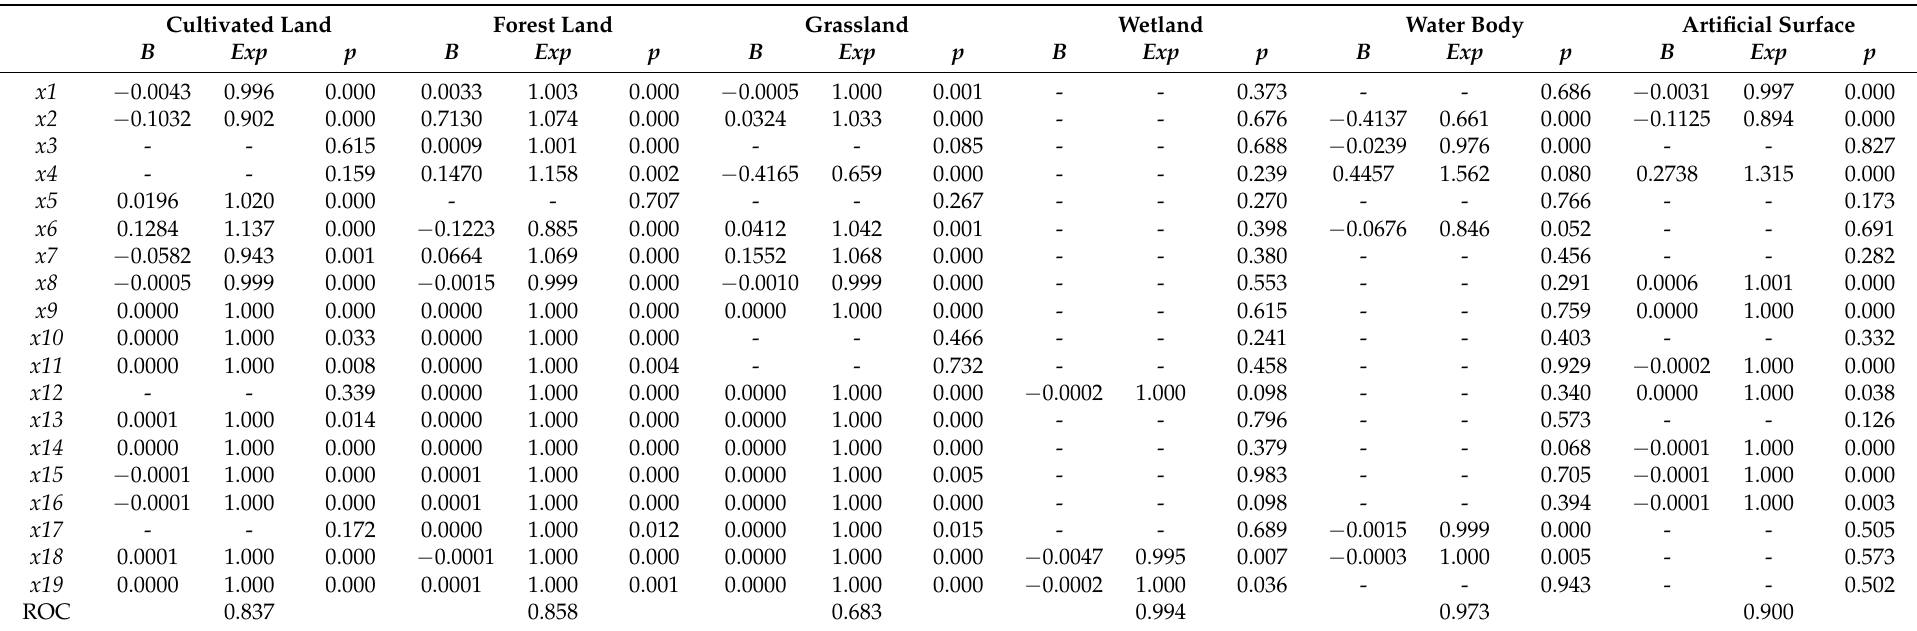
Table 2. Analysis of the drivers of different land-use